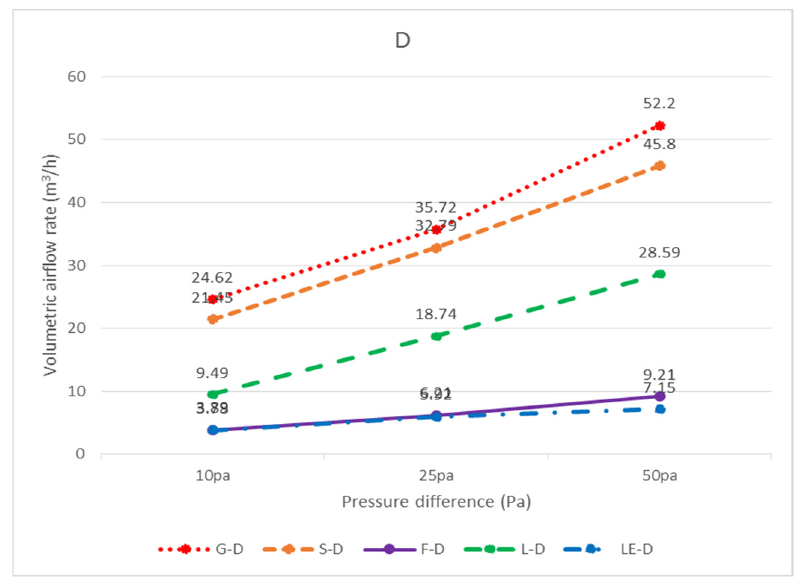
Figure 19. Unit leakage volume (m 3 /(h.m.)) of each specimen at each pressure difference with airflow top to bottom (D).